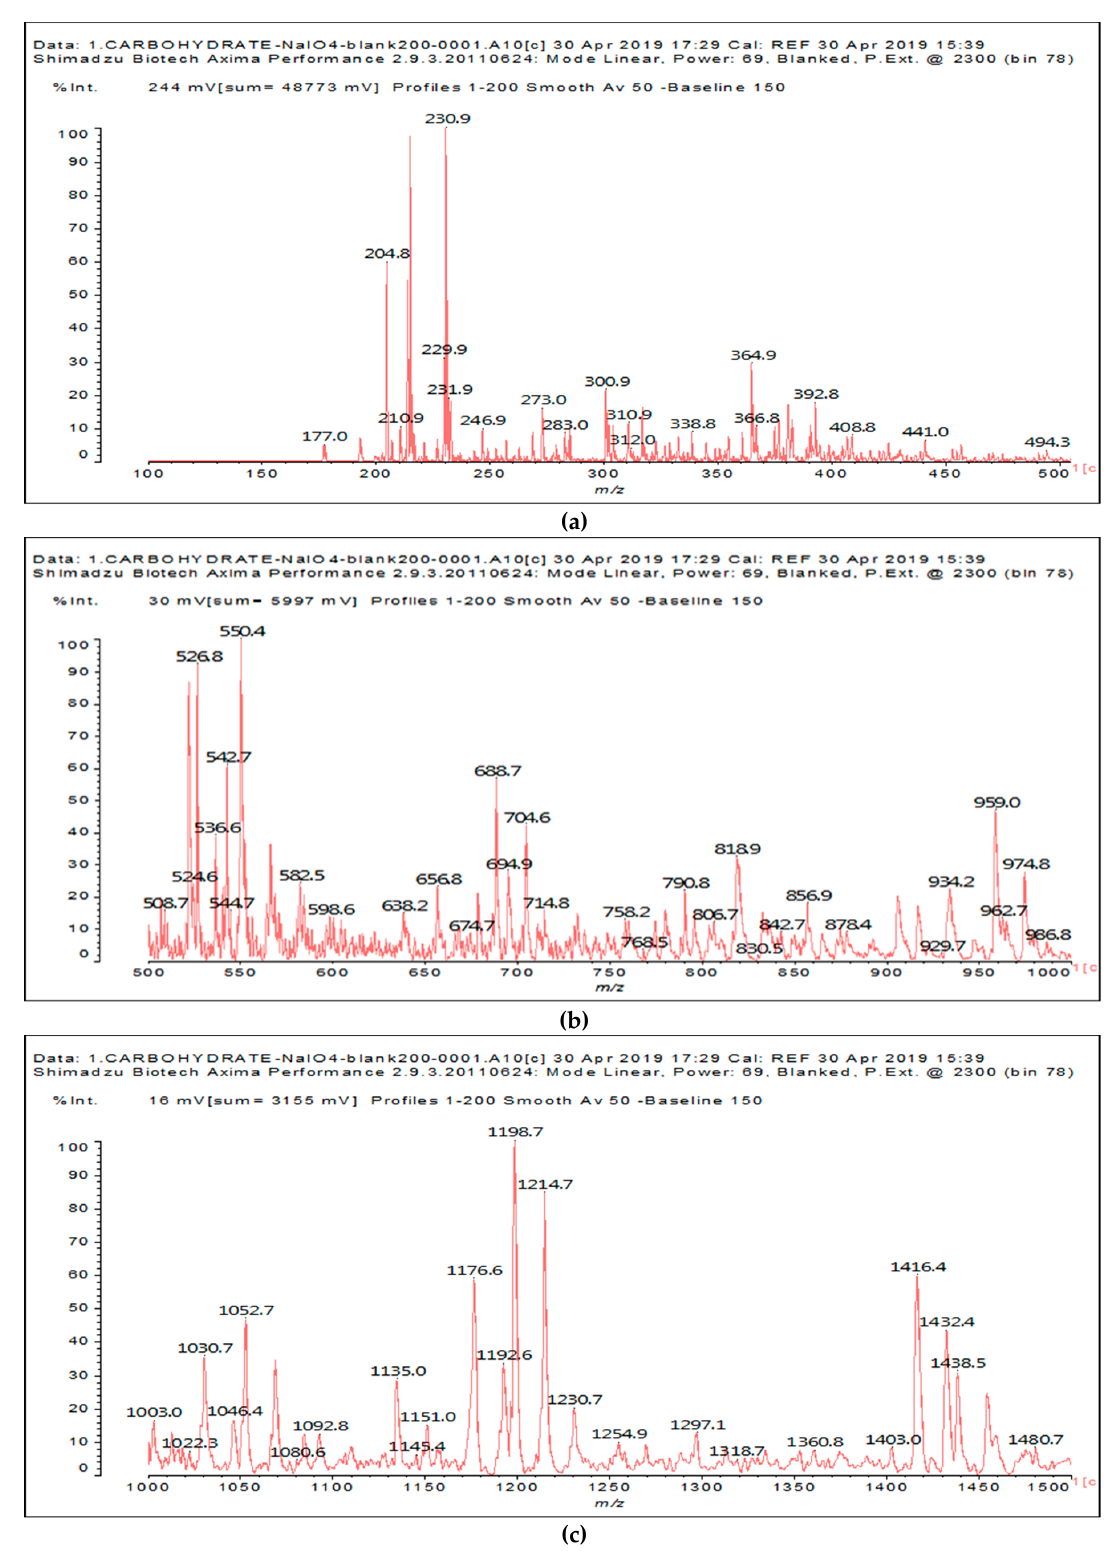
Figure 1. MALDI ToF spectra of insoluble soy flour carbohydrates after a treatment with sodium periodate at 120 °C for 1 hour. ( a ) 100 Da to 500 Da range. ( b ) 500 Da to 1000 Da range. ( c ) 1000 Da to 1500 Da range.